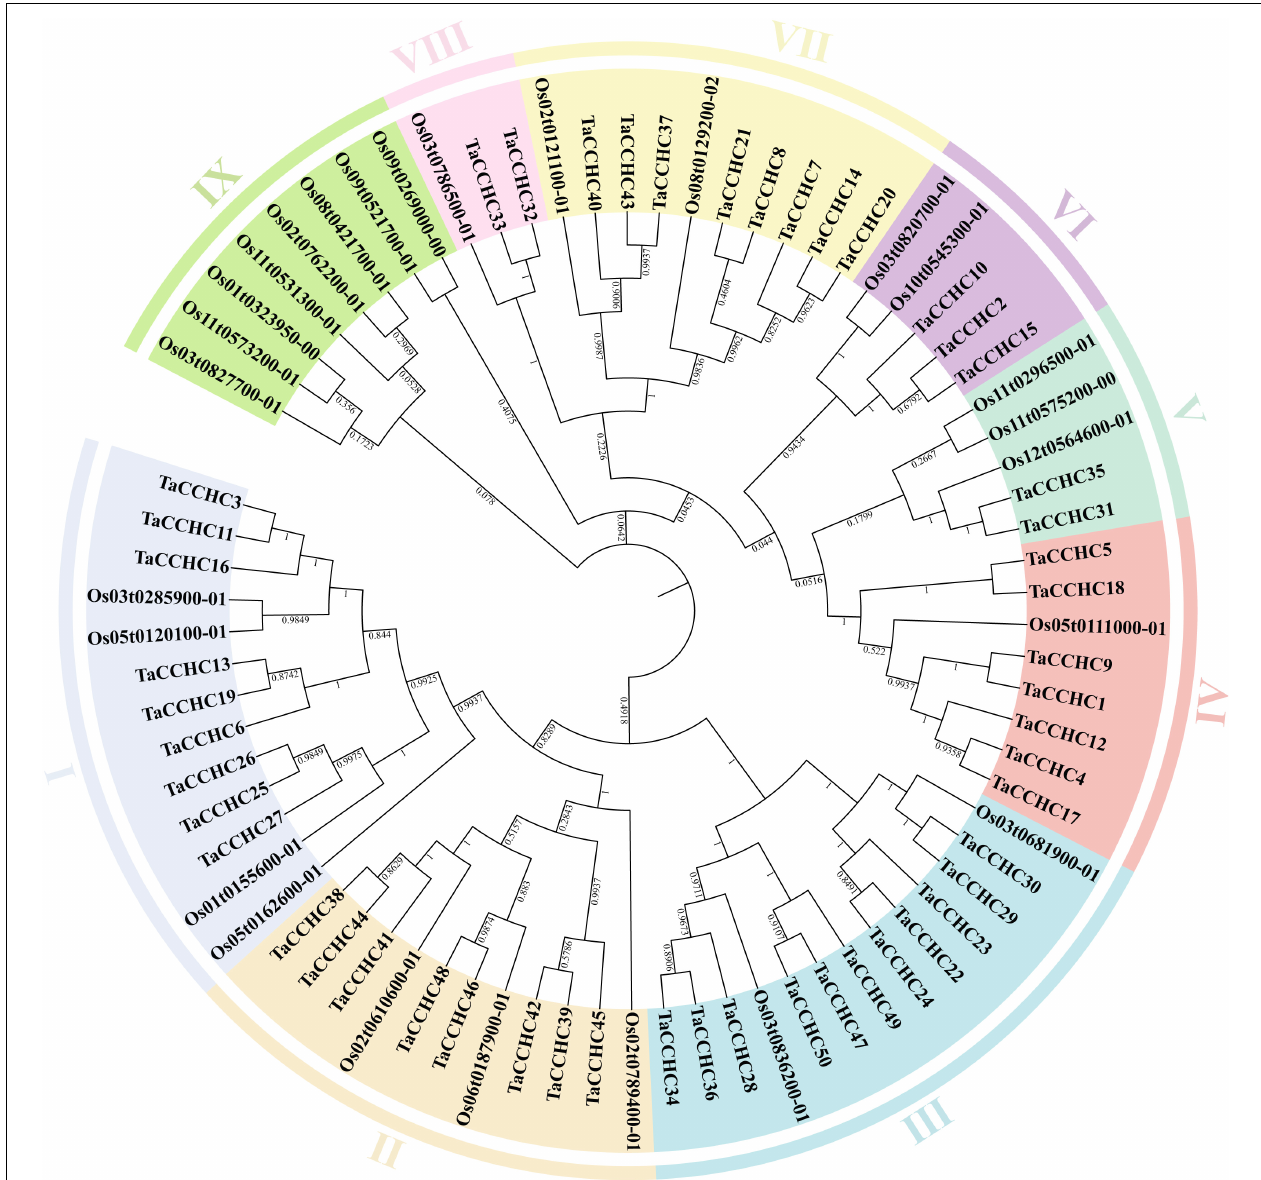
FIGURE 2 | Phylogenetic tree of CCHC-ZFPs in wheat and rice. The protein sequences were aligned using the ClustaX2, and the Neighbor-joining (NJ) phylogenetic tree was built using the MEGA 7.0 based on Poisson model. Different groups are indicated by different colors,